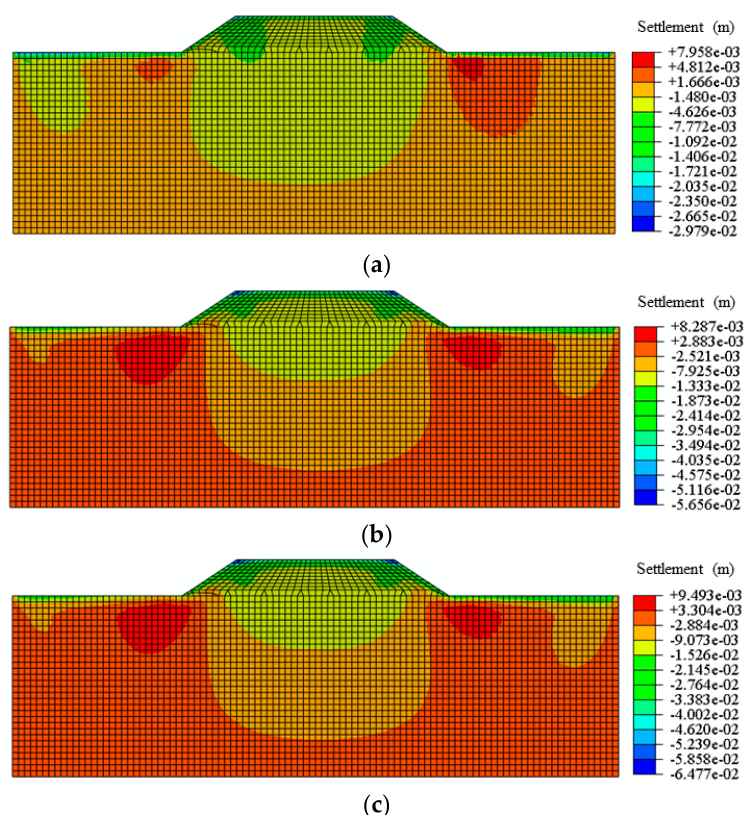
Figure 11. Cloud map of annual maximum settlement of subgrade: ( a ) 3 years; ( b ) 5 years; ( c ) 10 years.